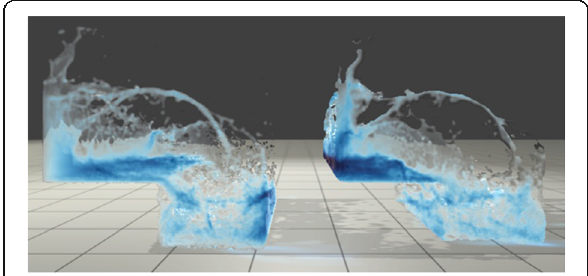
Fig. 12 Our direct particle-based rendering against isotropic kernel [34] (left, our direct rendering; right,